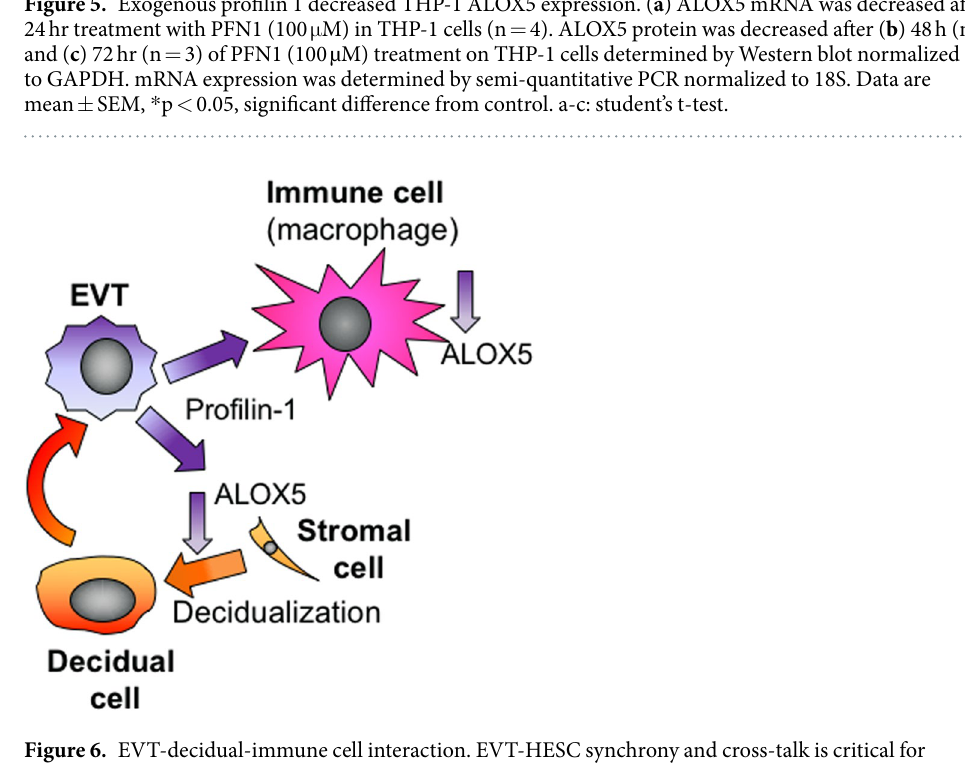
Culture conditions. EVTs were maintained in DMEM/F12 (Gibco) containing 10% FCS (Gibco) and 1% antibi- otics (penicillin, streptomycin, amphoceterin B; Gibco). EVTs were cultured on Growth-factor Reduced Matrigel (Corning) diluted 1:5 in serum-free DMEM/F12 to promote differentiation towards an EVT phenotype. HESC were cultured on plastic in DMEM/F12 containing 10% charcoal-stripped FCS (Gibco) and 1% antibi- otics prior to experimental use. HEK293 are an embryonic kidney epithelial cell line (ATCC). HEK293 cells were maintained in EMEM (Invitrogen) containing 10% FCS and 1% antibiotics. HTR8/SVneo (a gift from Charles Graham; authenticated 16/06/2016; MHTP Medical Genomics Facility; RRID:CVCL_7162) are a 1 st trimester EVT derived cell line. HTR8/SVneo cells were maintained in RPMI (Invitrogen) containing 10% FCS and 1% antibiotics. THP-1 cells (human monocyte cell line non-adherent; authenticated 16/06/2016; MHTP Medical Genomics Facility; RRID:CVCL_0006) were cultured in RPM1 containing 10% FCS and 1% antibiotics, before stimulated towards an adherent, macrophage phenotype by overnight treatment with phorbol 12-myristate 13-acetate (PMA; 12.5 ng/ml). All cells were cultured at 37 °C, 20% O 2 in a 5% CO 2 humidified culture incubator. CM collection Isolated primary first trimester EVT, HTR8/SVneo and HEK293 cells were cultured on 1:5 diluted growth-factor reduced Matrigel in 10% FCS DMEM/F12. CM was collected after 48 h. EVT CM was pooled (n = 5/group) from EVTs. HTR8/SVneo and HEK293 CM was pooled from n ≥ 3.